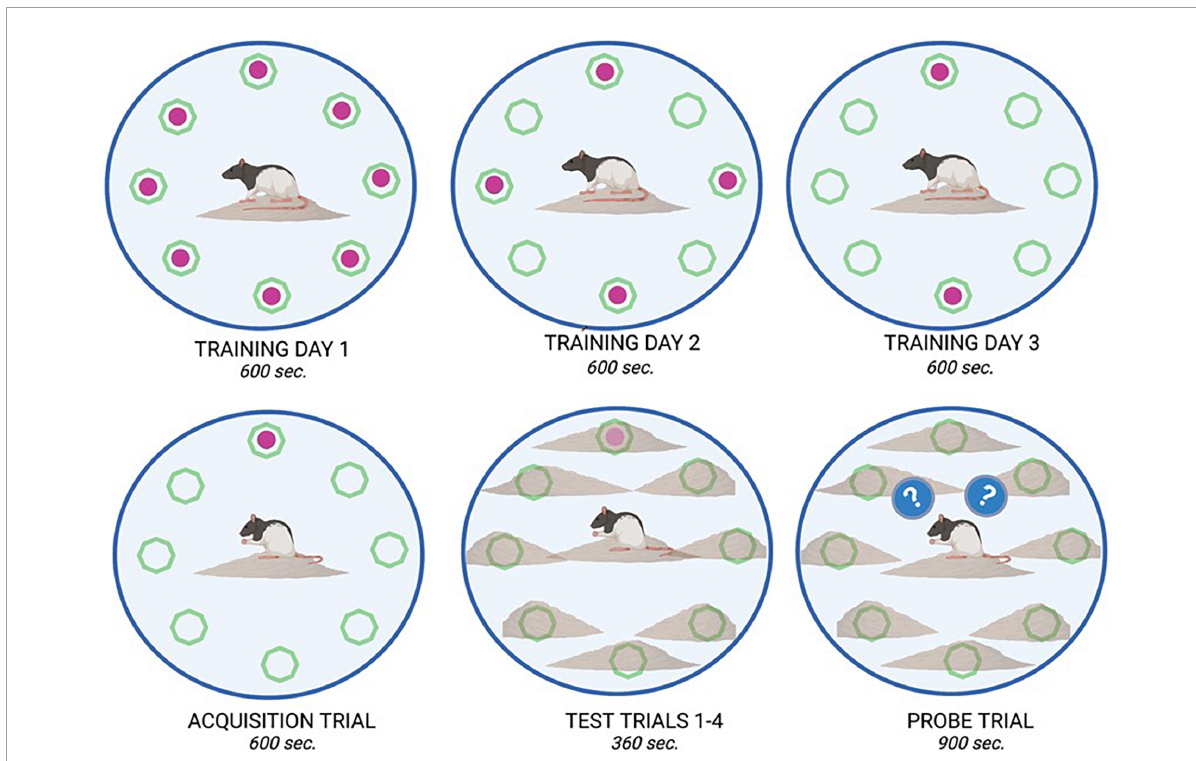
FIGURE2 Dry land maze task overview. The dry land maze consisted of an initial training day where animals could retrieve a sweet cereal reward from all available wells (8) within a 600 s time period. On training day 2, only four of the eight wells were baited, and on training day 3, only two of the eight wells were baited. On the fourth day, an acquisition trial was run where only one well was baited with a food reward. This location remained consistent for all animals. On the Test day, four trials were run consecutively, in which the food reward was placed in the same location as in the acquisition trial; however, it was buried beneath bedding to increase the complexity of the test. Animals were allowed 360 s. per trial to retrieve the reward. On the final day, a probe trial (900 s) was run in which no food reward was placed in any well. From this trial, measures such as latency to approach, and time spent in proximity to the previously baited well were recorded as observations of learning and